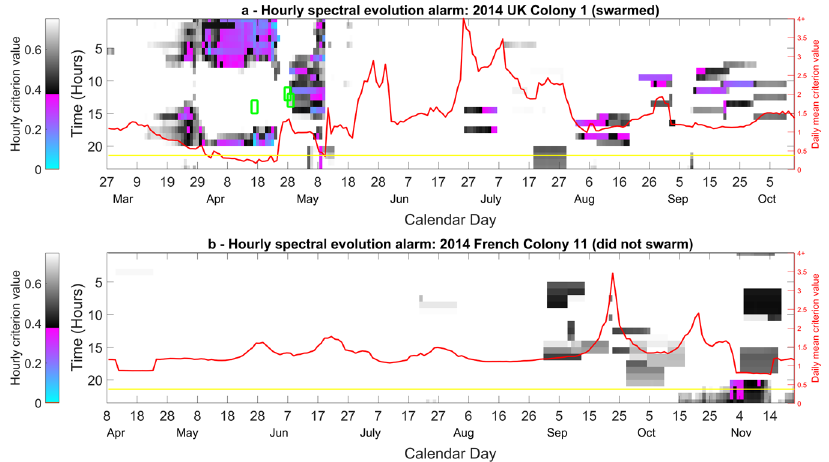
Figure 6. Swarming alarm based on the 10-day evolution of spectra for a colony that ( a ) swarmed, situated at Nottingham Trent University and ( b ) did not swarm, situated at INRA, France. Each colony was monitored across the active season in 2014. The colour coding is identical to that of Fig. 3. Green rectangles display the timings of three swarms that occurred within this dataset. Super imposed is another graph with the y-axis (at right) being the daily mean criterion value computed from data between midnight and 5:00 AM; the yellow line displays the alarm threshold. This figure was created using the MATLAB (R2018b) software (uk.mathworks.